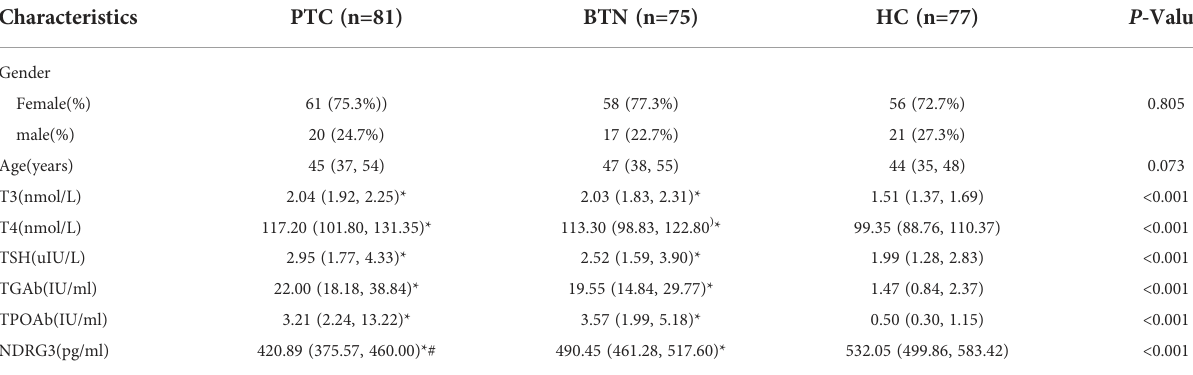
TABLE 1 Baseline Characteristics and comparison of experimental indexes.